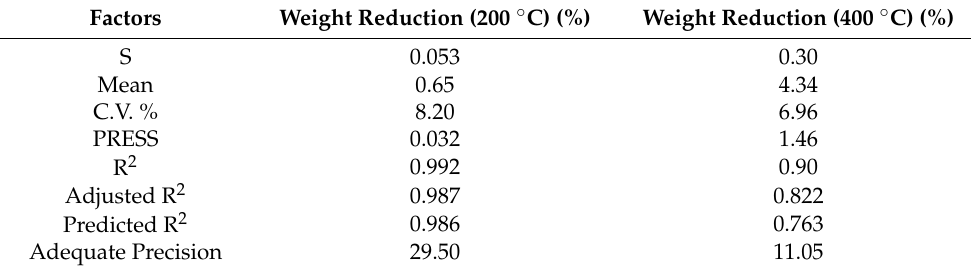
Table 10. Coefficient of determination for weight reduction models.